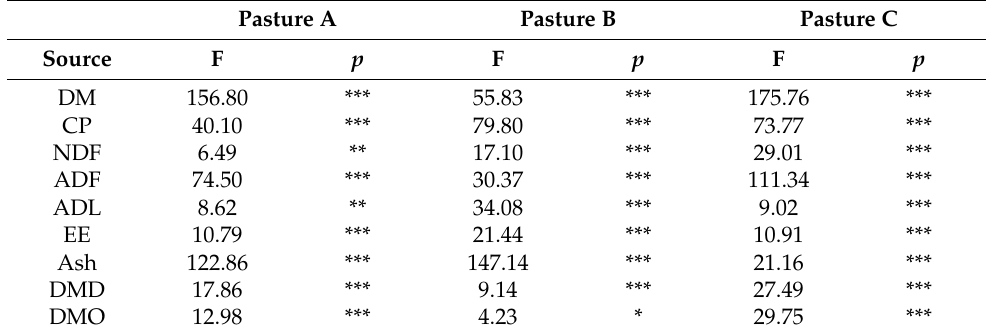
Table 3. F and p values from one-way ANOVA of dependent variables (dry matter—DM,